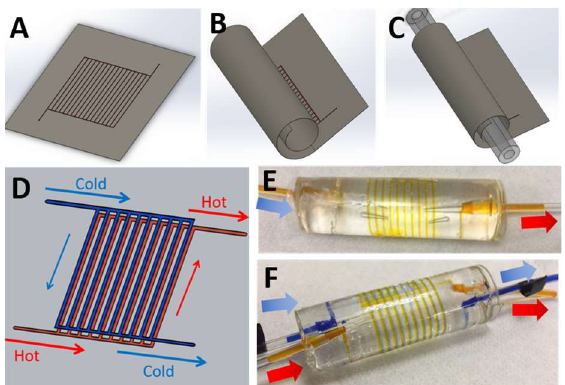
Figure 1. The illustration of the roll-up microfluidic system made from polymer thin film. ( A ) The thin-film microfluidic system was made by casting polymeric resin (PDMS) onto the mold containing the microfluidic channels. ( B ) After curing, the PDMS thin film was flexible enough to be rolled up around the PDMS center core, also made via casting. ( C ) The thin-film and center core were bonded together by using oxygen plasma activation to obtain the three-dimensional (3D) spiral microchannel. This method allows for the creation of multiple fluidic layers by rolling multiple microchannel thin films (i.e., hot-water layers and cold-water layers) around the core, thereby forming a heat exchanger device with two fluidic streams. The dual-channel device contains hot and cold fluid running in a counter-cross flow arrangement, as shown by the red and blue arrows for hot and cold water streams, respectively. ( D ) The rolled-up microfluidic device with single layer of microchannel was fabricated and demonstrated as a heat-sink application. ( E ) The rolled-up microfluidic device with two microchannel layers was employed as heat exchanger device. ( F ) The arrows indicate the fluidic direction inward or outward relative to the device. The diameter of the center core was approximately 20